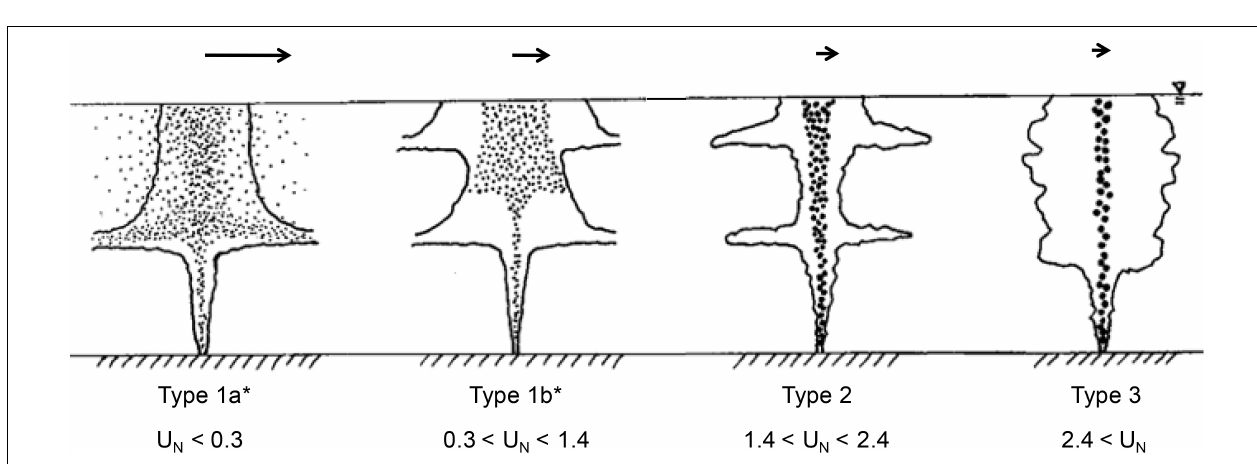
FIGURE 3 | A typology for stagnant multiphase plumes in stratification showing secondary intrusions in Type 1b* and 2 plumes. The arrow length indicates qualitatively the width of the particle distribution. Image adapted from Chan et al. (2014) with